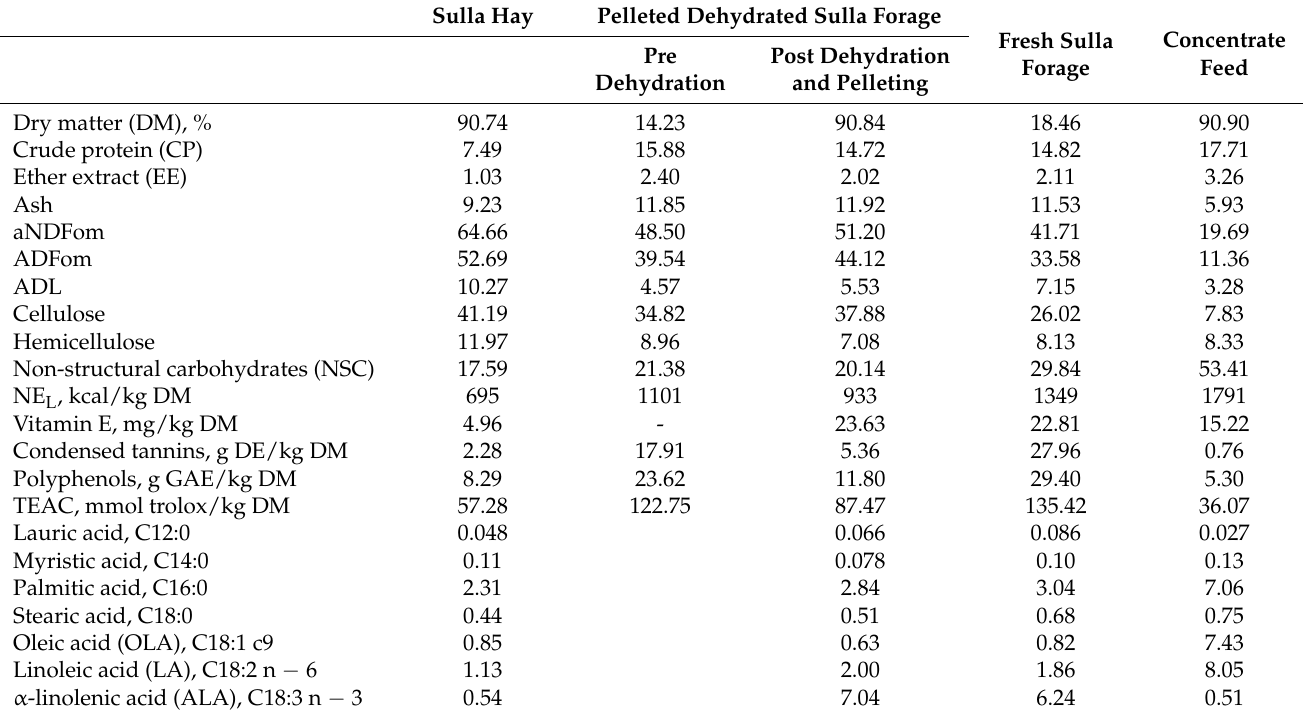
Table 1. Chemical composition (% DM) and fatty acid content (g/kg DM) of forages and concentrate feed received by ewes. Sulla